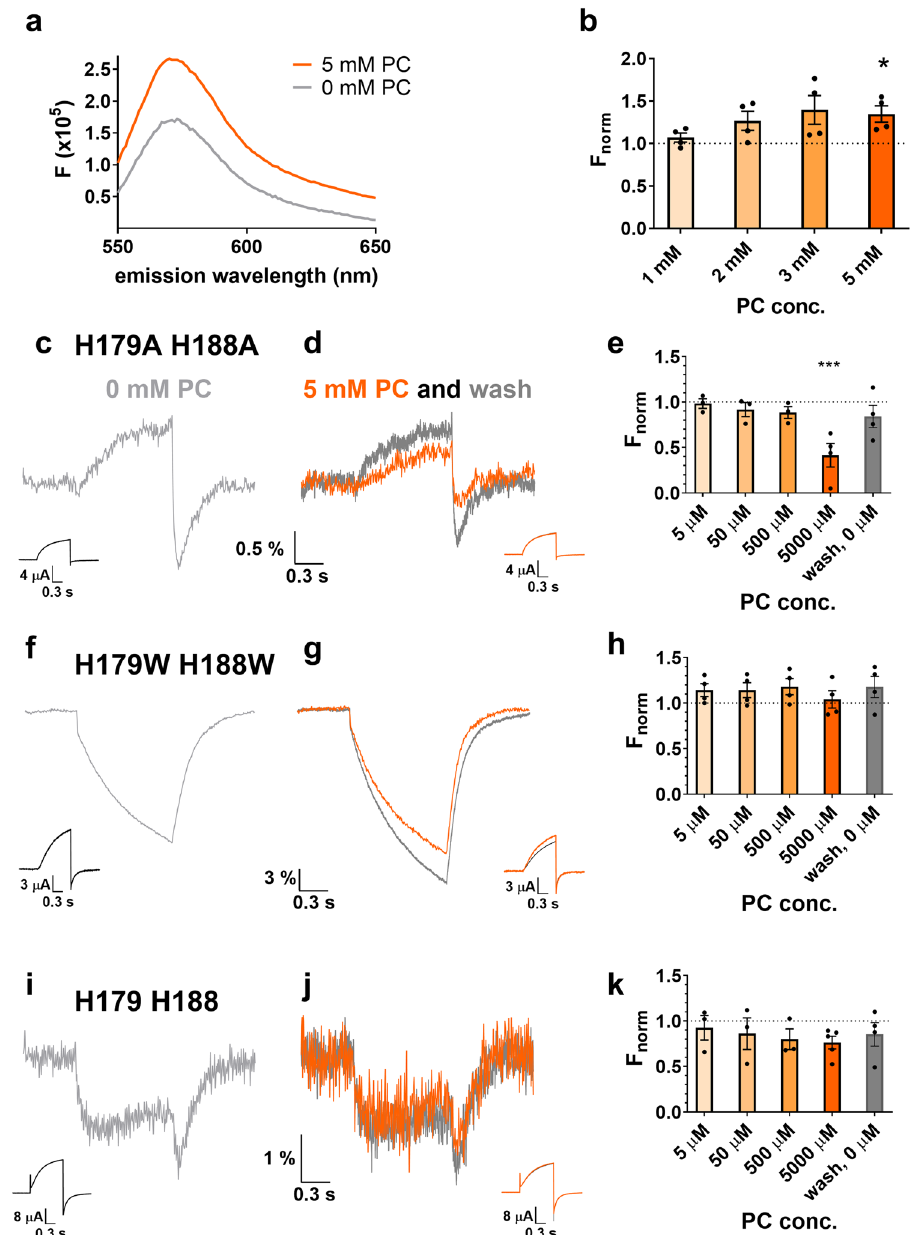
Fig. 5 Effect of PC (phosphatidylcholine) on TAMRA-MTS fl uorescence. a Effect of 5 mM PC (phosphatidylcholine) on the emission spectrum of TAMRA-MTS in an aqueous solution, in a cuvette (excitation wavelength: 535 nm). b TAMRA-MTS fl uorescence in solution in the presence of PC at different concentrations normalized to the control solution (0 mM PC) measured at the wavelength of maximum emission ( N = 5). Representative fl uorescence responses and proton currents to a voltage step from − 60 mV to + 100 mV from oocytes labeled with TAMRA-MTS on E241C, expressing the constructs Ci-Hv1 H179A/H188A ( c , d , e ), H179W/H188W ( f , g , h ) and H179/H188 ( i , j , k ). c , f , i panels show the control VCF signals in the absence of PC, before PC application, while the ( d , g , j ) panels show VCF signal in the presence of 5 mM PC (orange) and after wash (dark grey). Bar charts in panels e , h , k summarize the average PC effects at different concentrations along with washout. Vertical axis shows Δ F tail /F h values, normalized to the control value (0 mM PC). Error bars represent SEM, *indicates signi fi cant difference (* p < 0.05, *** p < 0.001) compared to the control value using one-way ANOVA. ( N = 3 at least for e and k ; N = 4 for h